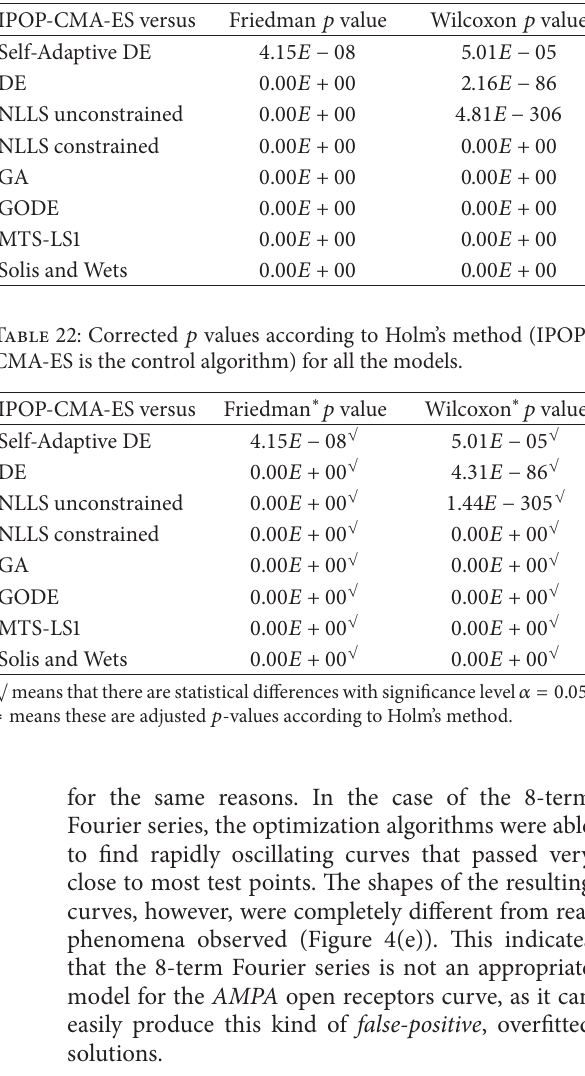
Table 21: Raw 𝑝 values (IPOP-CMA-ES is the control algorithm) for all the models.